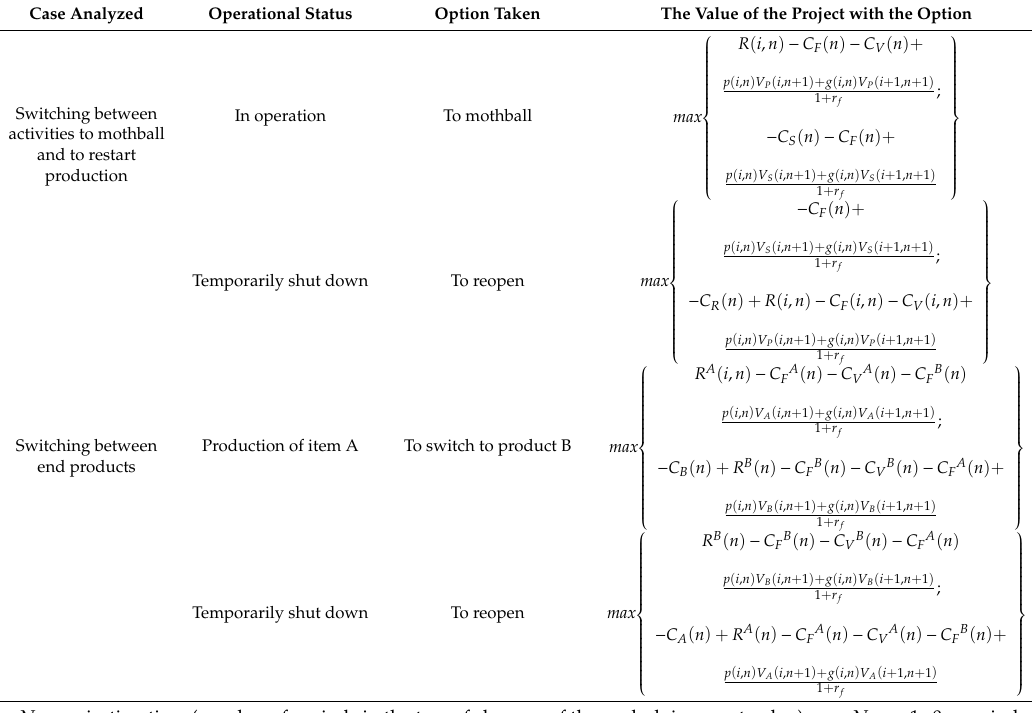
Switching between activities to